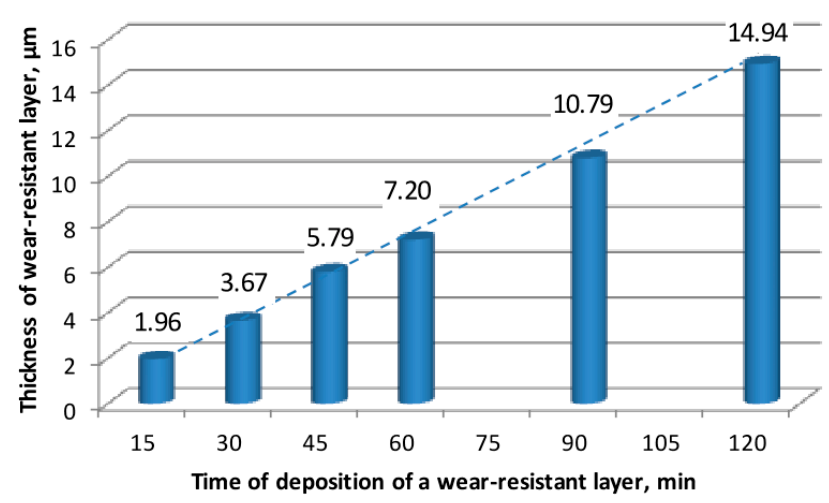
Figure 4. Between the thickness of the wear-resistant coating layer and its deposition time.